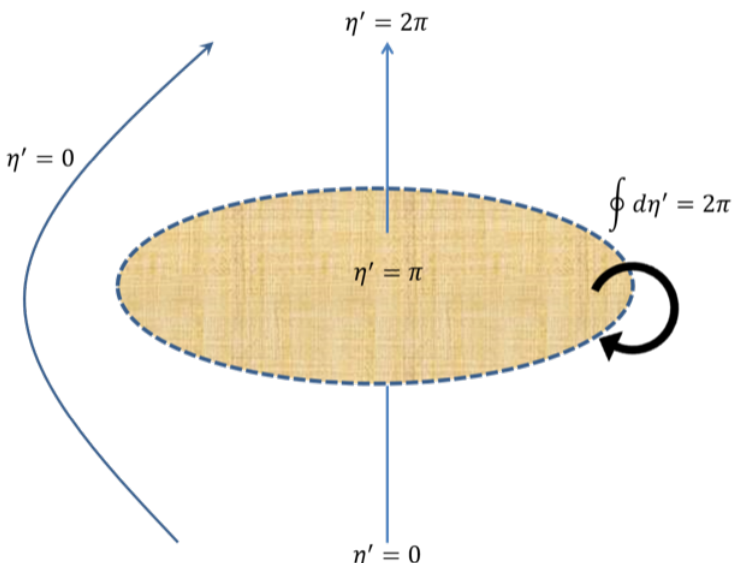
= 1 baryon of [ 5 ] . In the figure, the pancake is schematically the η (cid:48) = π Figure 1: The N f sheet where the CS theory lives. For any closed trajectory that goes through the pancake, η (cid:48) winds from 0 to 2 π